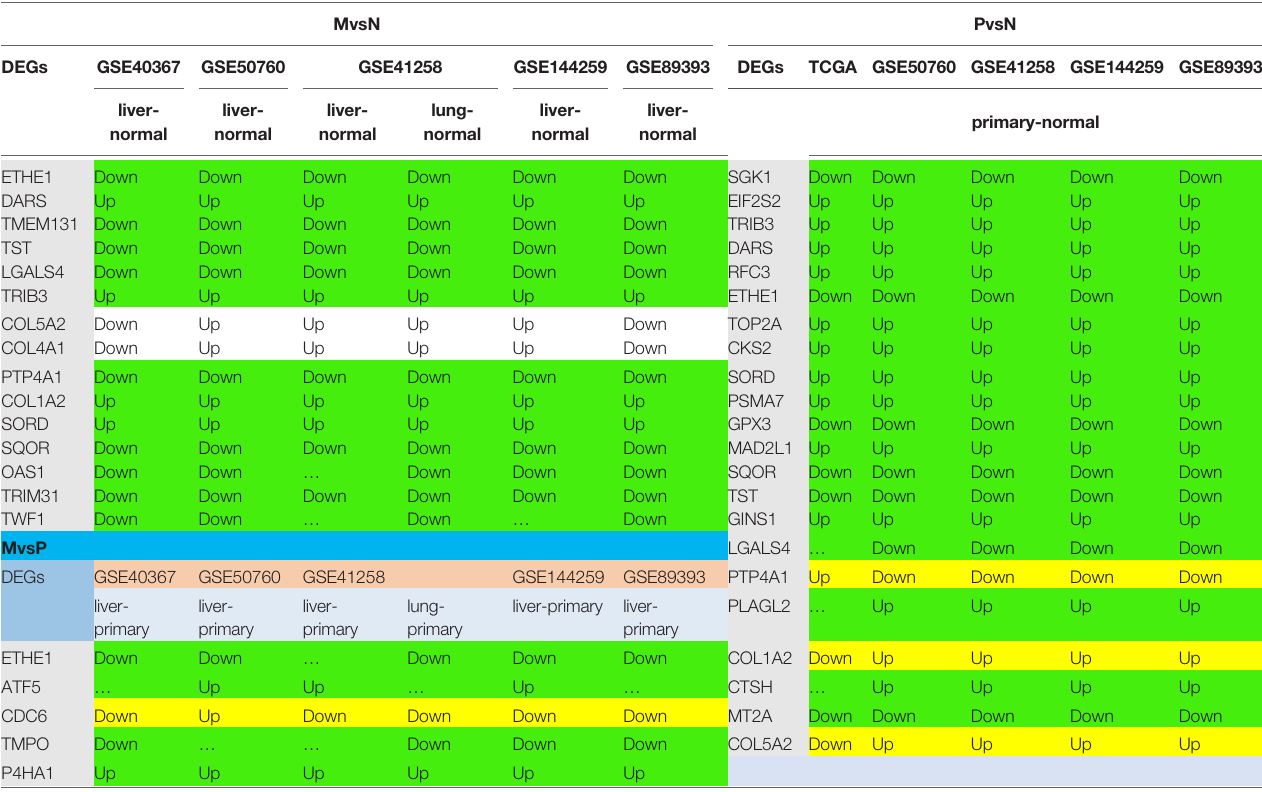
TABLE 2 | Illustration of Core network DEGs in Validation